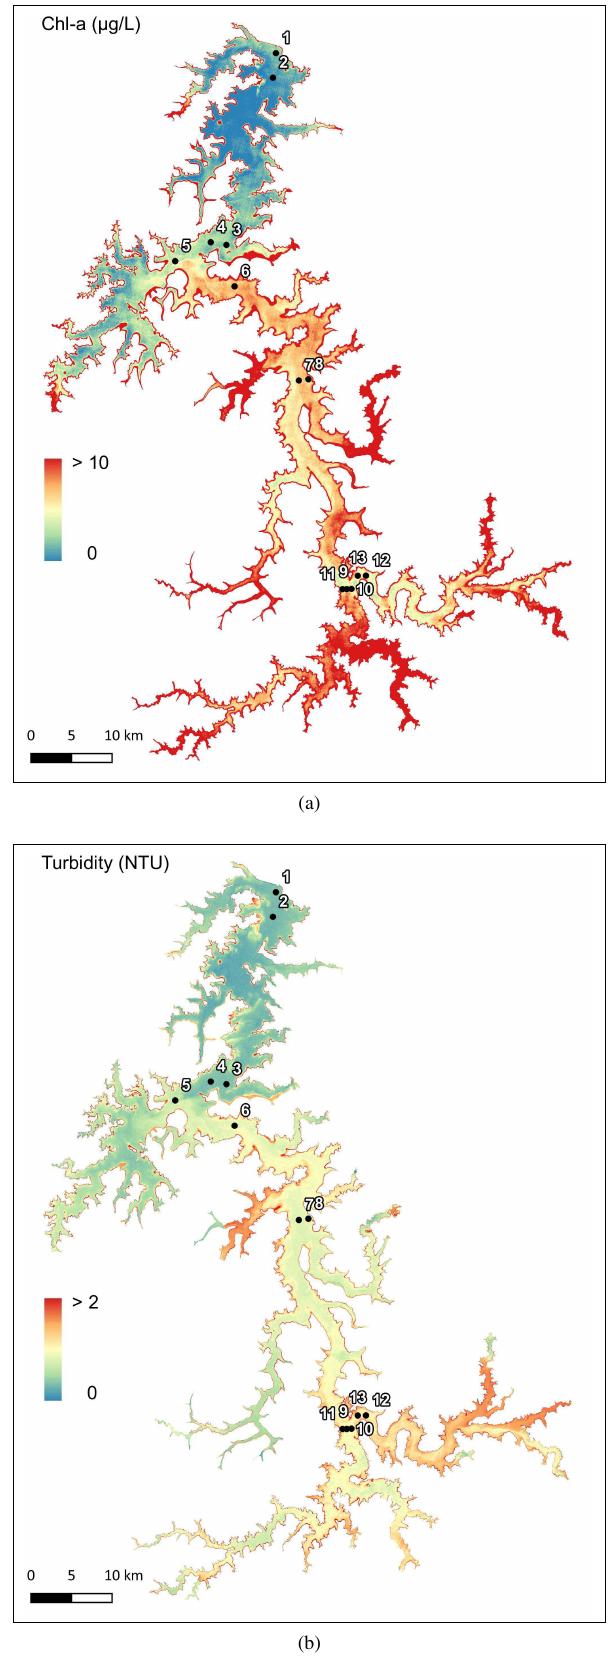
Figure 3. Maps produced using the chlorophyll-a (a) and turbidity (b) models for the Sentinel-2 MSI